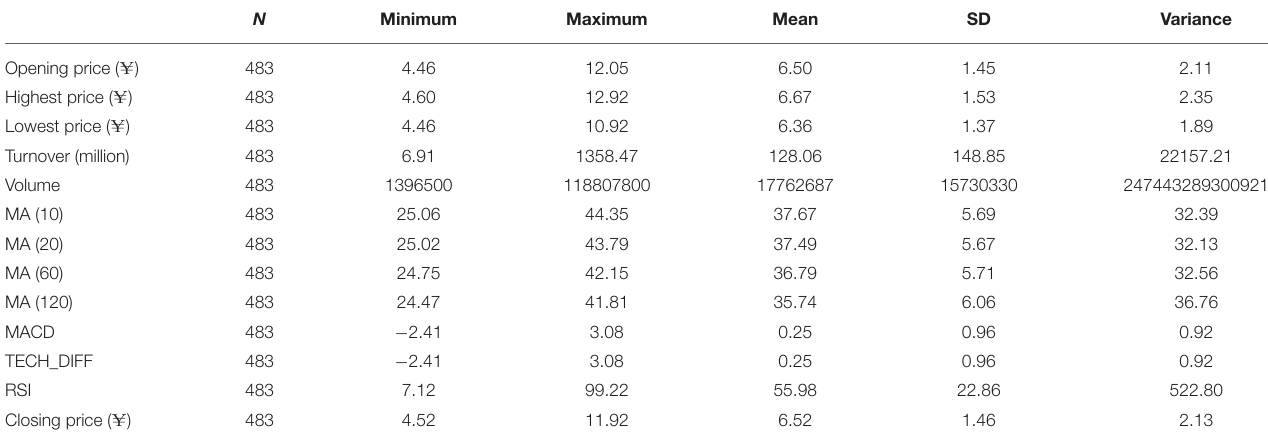
TABLE 1 | The descriptive statistical value of technical indexes for Utour Group Co., Ltd. N Minimum Maximum Mean SD Variance